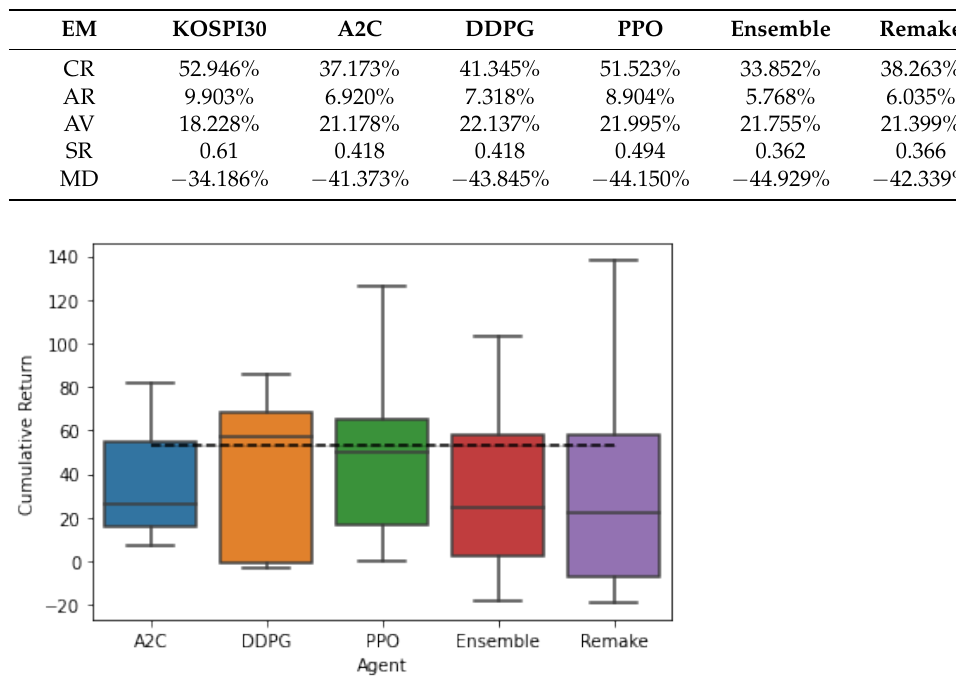
Figure 4. Cumulative returns of each agent with the average return of the top 30 KOSPI stocks (the dotted line is the benchmark index, which is the cumulative return of the KOSPI30).